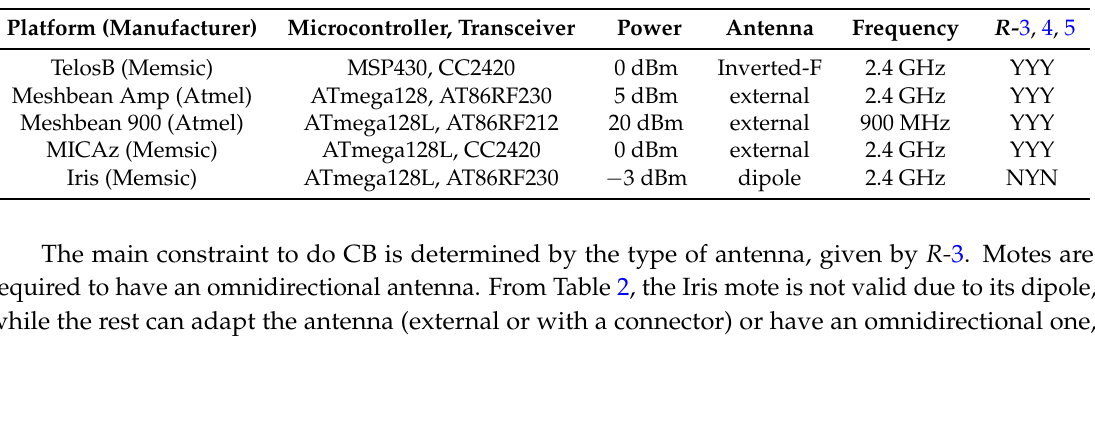
Table 2. Main features of the most popular commercial